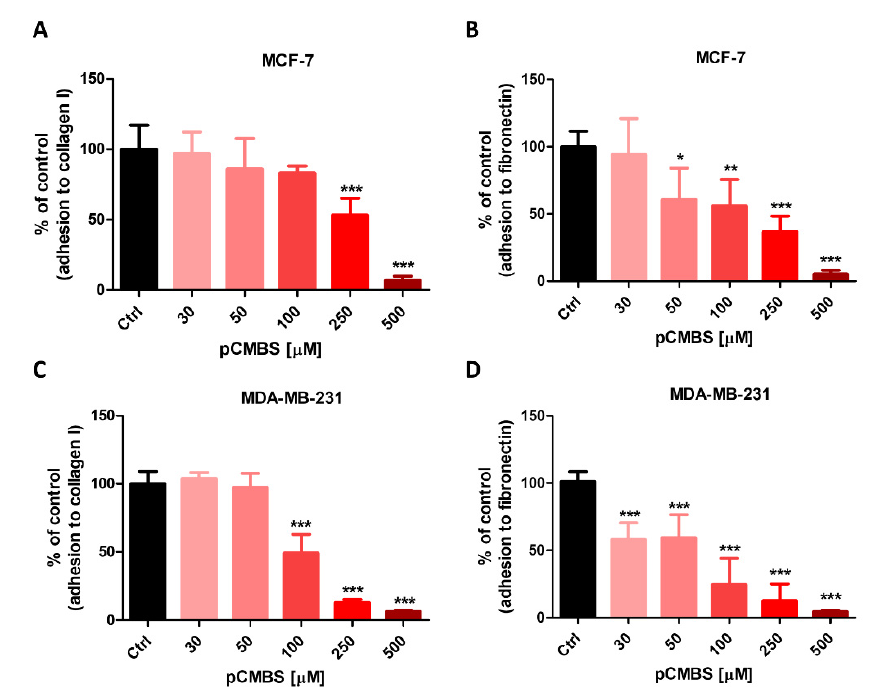
Figure 5. Effects of thiol blocker, pCMBS on adhesion of cancer cells to fibronectin and collagen type I. Effect of inhibiting ecto-sulfhydryls by p-chloromercuribenzene sulphonate (pCMBS) on adhesion of MCF-7 ( A , B ) and MDA-MB-231 ( C , D ) cells to collagen type I and fibronectin. Data represent mean ± SD of three independent experiments. Statistical analysis was performed using one-way ANOVA followed by Dunnett’s multiple comparisons test (* p = 0.05, ** p = 0.01, *** p =